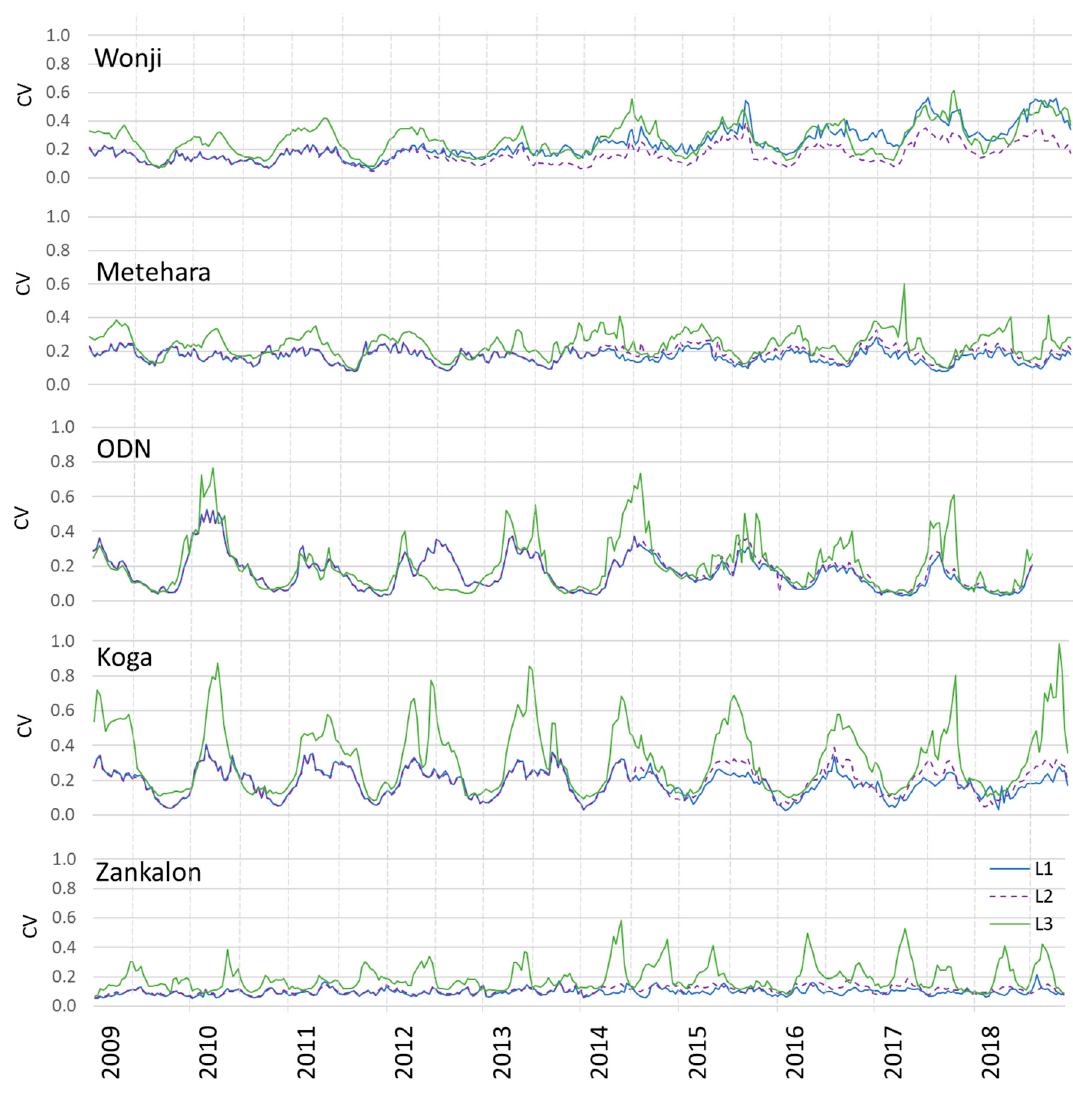
Figure 6. Dekadal intra-plot CV of ETIa for each irrigation scheme.